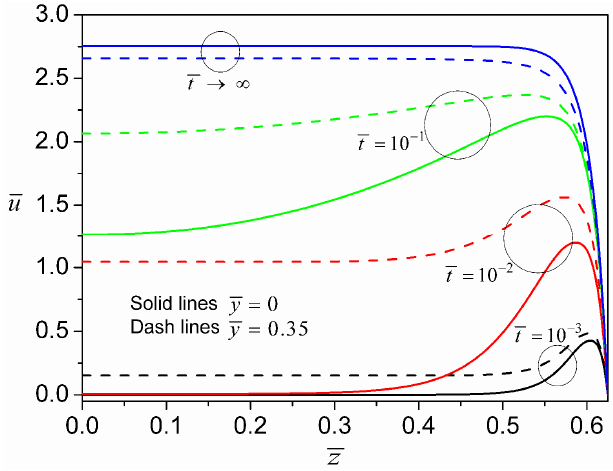
Figure 3. Transient evolution of axial velocity profiles for a power-law fluid with n = 0.8 and ψ w = − 1 due to an applied DC electric field E 0 = 0